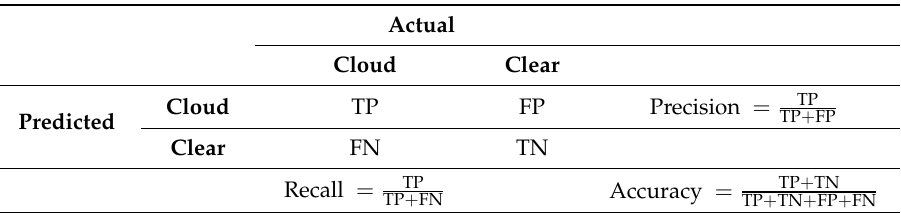
Figure 11. Numerical analysis of RBR, S, NRBR, and ARGD, and image comparison for the corresponding cloud recognition algorithms: ( a ) Numerical analysis and image comparison for the clear sky; ( b ) numerical analysis and image comparison for the cloudy sky; ( c ) numerical analysis and image comparison for the overcast sky. Table 4. Confusion matrix and evaluation